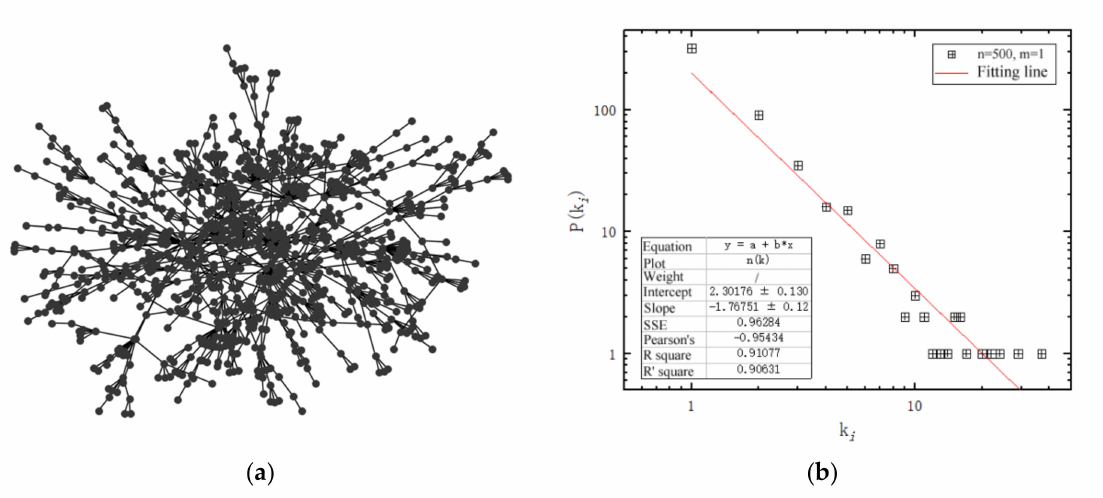
Figure 3. BA scale-free network simulation diagram: ( a ) Network topology; ( b ) Network degree distribution